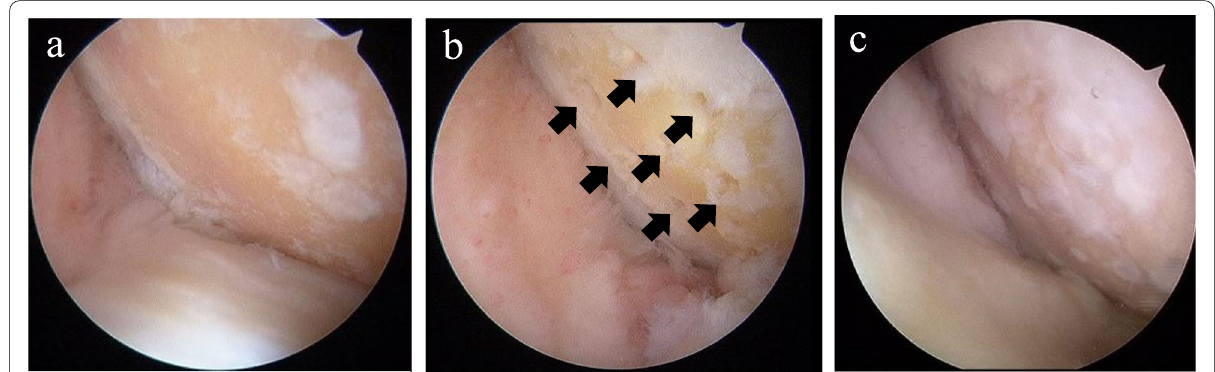
Fig. 3 Arthroscopic views. a Full-thickness articular cartilage defect of the lateral femoral condyle. b Microfracture (black arrows) for a cartilage defect in the lateral femoral condyle. c) Regenerated cartilage of the lateral femoral